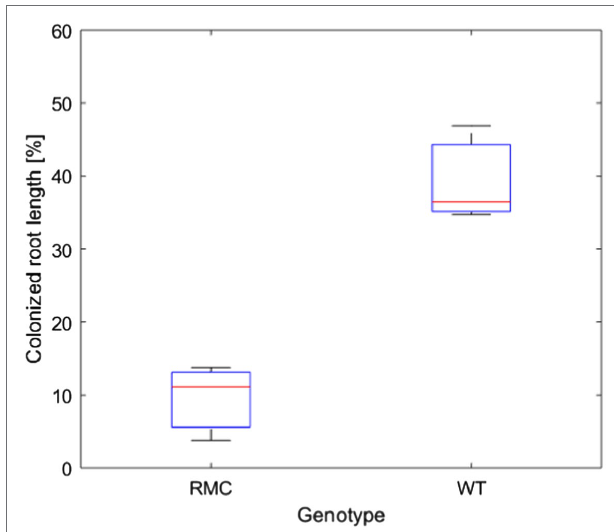
FIGURE 2 | AMF abundance assessment in roots of reduced mycorrhiza colonization (RMC) and wild-type counterpart (WT). AMF colonization was four times higher in WT compare to RMC (value of p < 0.05).